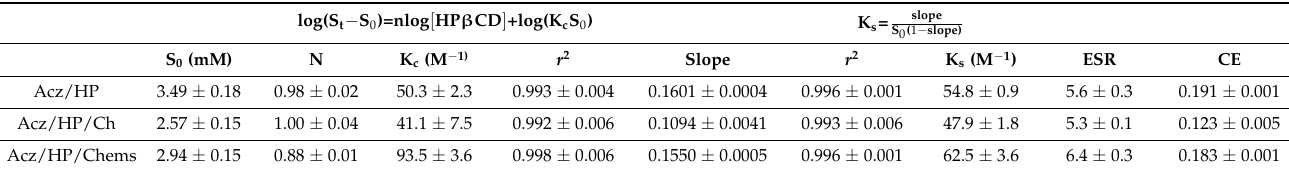
Table 2. Characteristics of the Acz/HP β CD complexes. S 0 : solubility of Acz in the absence of HP β CD; n: slope of the logarithmic plot; K c : cumulative complex stability constant; K s : apparent stability constant; ESR: enhanced solubility ratio; CE: complexation efficiency.